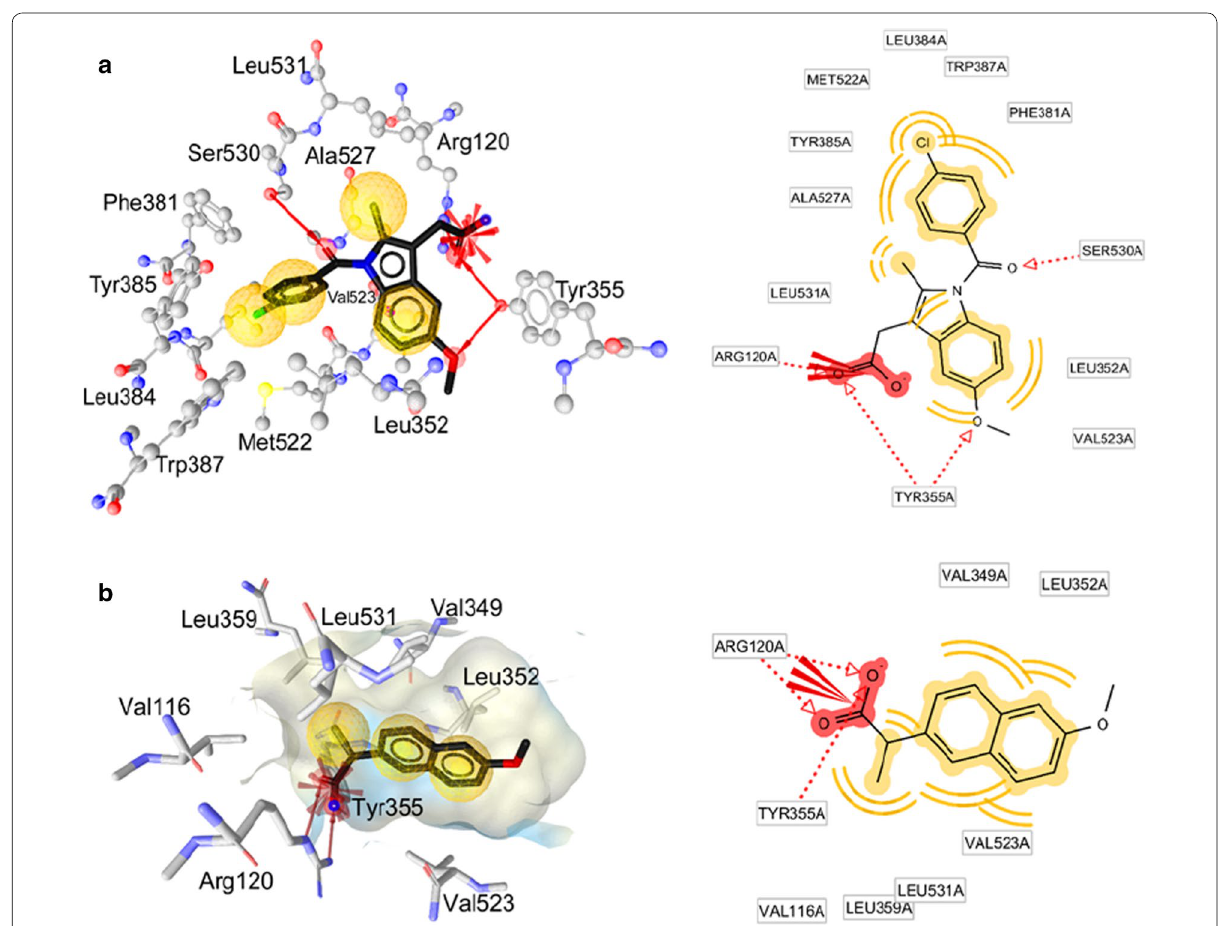
Fig. 5 a Binding mode of indomethacin co‑crystallized with COX‑2 as 3D (left) and 2D (right), PDB entry 4COX. b Binding mode of naproxen co‑ crystallized inside COX‑2 active site as 3D (left) and 2D (right), PDB entry 3NT1. Pharmacophore features created using LigandScout. Red arrows: H‑bonds, red star: negative ionizable feature, yellow spheres: hydrophobic contacts